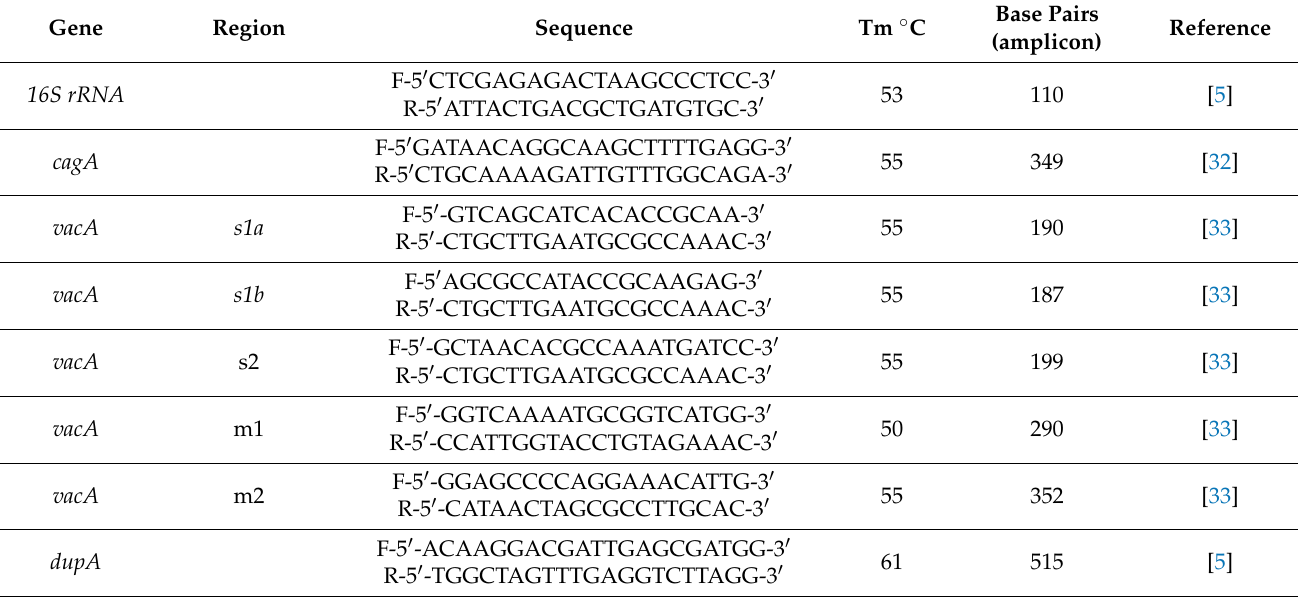
Base Pairs (amplicon)